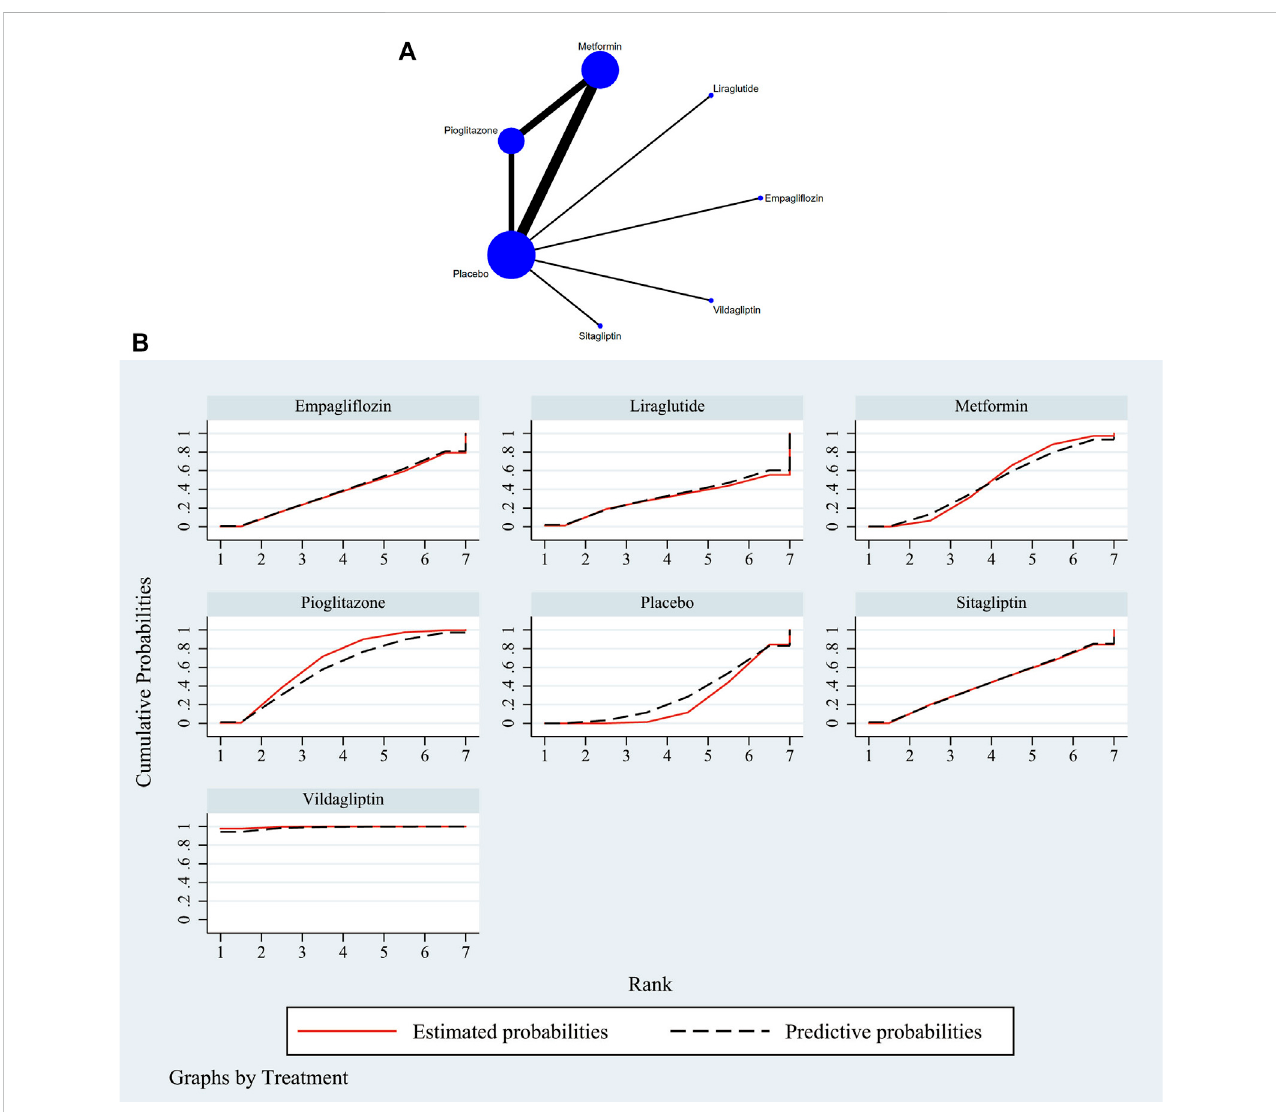
FIGURE 3 (A) NMA fi gure for AST. Each node stands for a different treatment. The size of each node is based on how many people were given that treatment. The lines show direct comparisons, and the width of the line depends on how many trials were done. (B) SUCRA plot for AST. The cumulative rank likelihood of each therapy is represented by the area under the curve, with bigger areas denoting higher